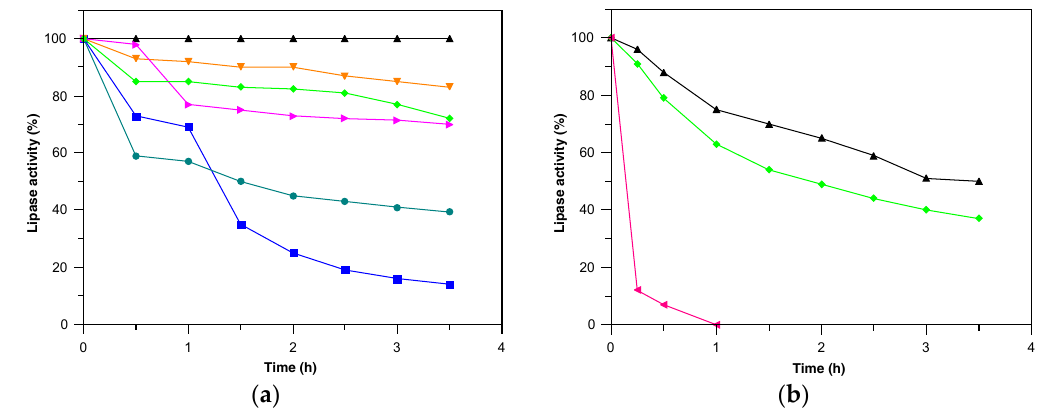
Figure 2. Thermal inactivation of the Penicillium sp. (CBMAI1583) lipase derivatives. Incubation was carried out in 5 mM sodium phosphate buffer pH 7.0 at ( a ) 50 and ( b ) 60 °C. Lipase activity (%) of ( ▲ ) Toyopearl butyl 650 M; ( ■ ) Lewatit VP OC 1600; ( ● ) octadecyl Sepabeads; ( ▼ ) butyl Sepharose; ( ► ) phenyl Sepharose; ( ♦ ) octyl Sepharose and ( ◄ ) CNBr derivatives. Data presenting deactivation constant and half-lives of the different derivatives at different temperatures are summarized in Table 2. Due to the high stabilization, adsorption on hydrophobic supports showed to be a successful alternative for immobilization of the Penicillium sp. (CBMAI 1583) lipase. These results are better than others previously reporting two-fold stabilization for the TLL immobilized on poly-hydroxybutyrate particles and CRL ( Candida rugosa lipase) immobilized on Sepabeads [24,25].